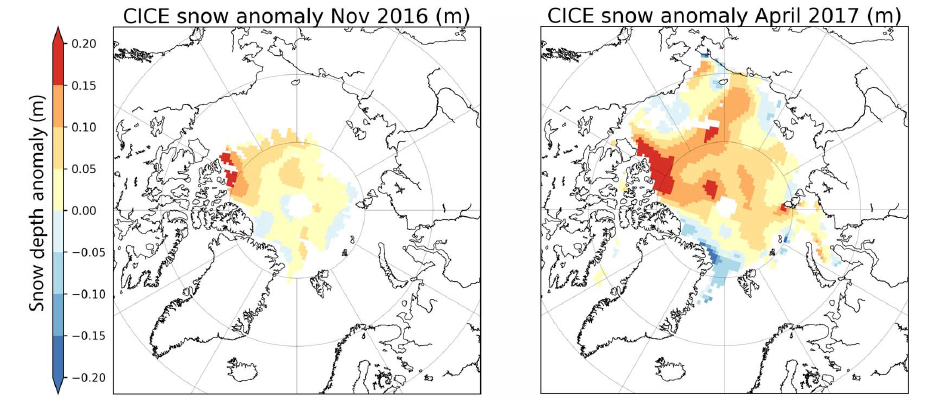
Figure 7. Snow depth anomaly for November 2016 (relative to 2010–2016) and April 2017 (relative to 2011–2017) from CICE.